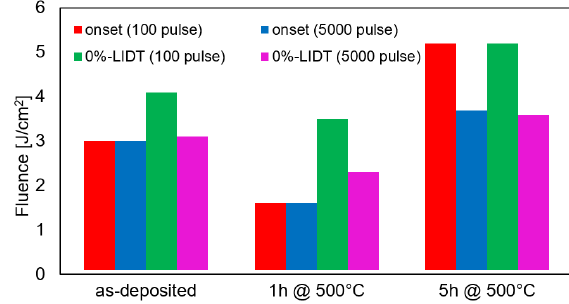
Fig. 2. Damage onsets as well as the 0%-LIDT values after 100 and after 5000 pulses for the different samples. We would like to thank the canton of St-Gallen and the Principality of Liechtenstein for supporting